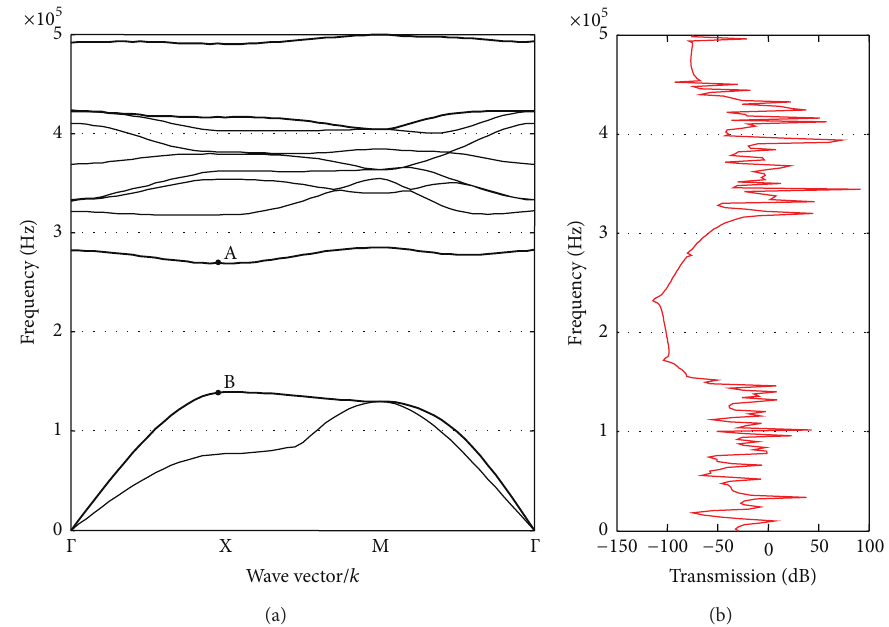
Figure 2: The dispersion curves of the phononic crystal with microcavity structure (a) and the transmission spectra of the phononic crystal with microcavity (b).